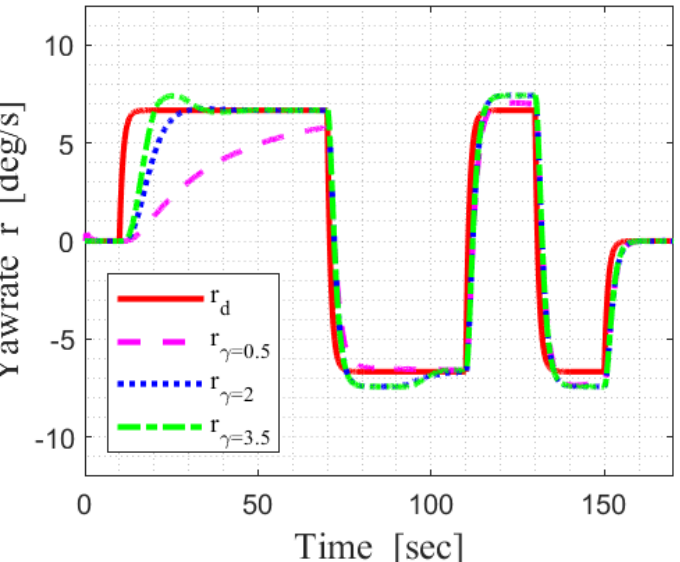
Figure 8. Comparison of yaw − rate tracking according to the value of adaptive gain γ